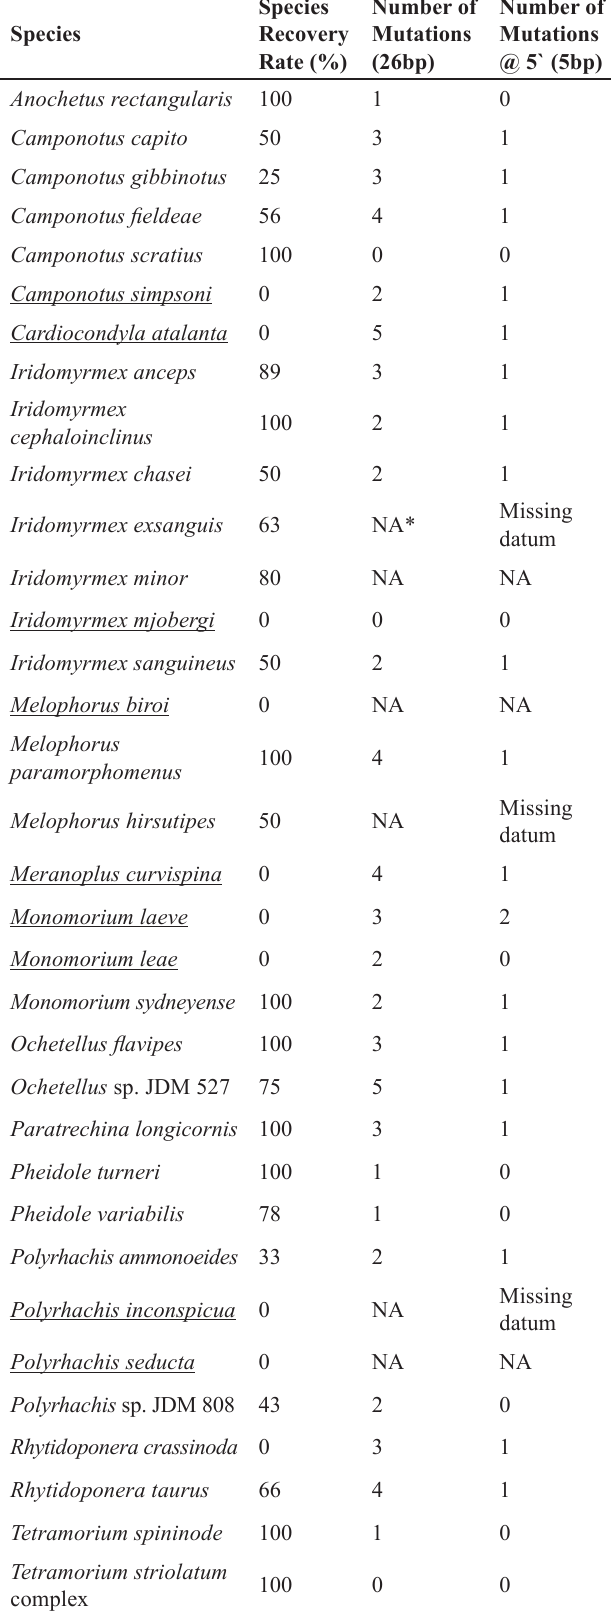
Table 5 . Comparison of species recovery over all sites and number of mutations within the CI-J-1715 priming site. The species that were not recovered are